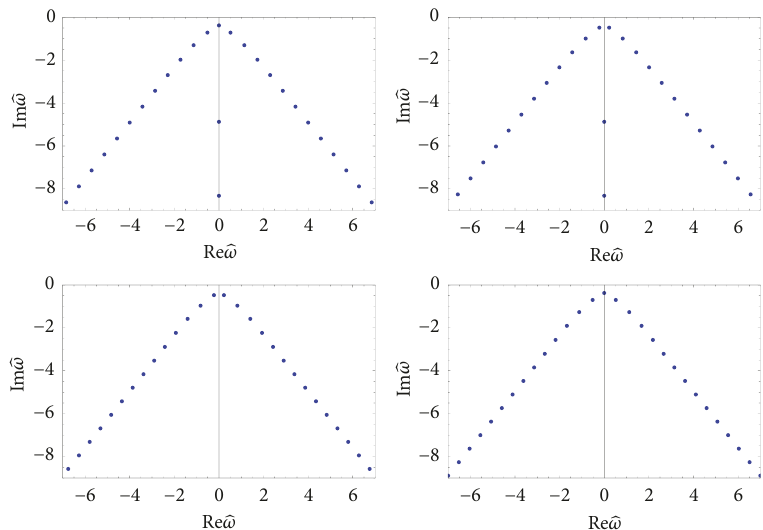
Figure 4: QNMs (blue spots) of the gauge mode for |𝛾 1 | = 0.001 (the panels above are for 𝛾 1 = −0.001 and the ones below for 𝛾 1 = 0.001 ) and ̂𝛼 = 0 . The left panels are the QNMs of the gauge mode and the right ones are that of the dual gauge mode.